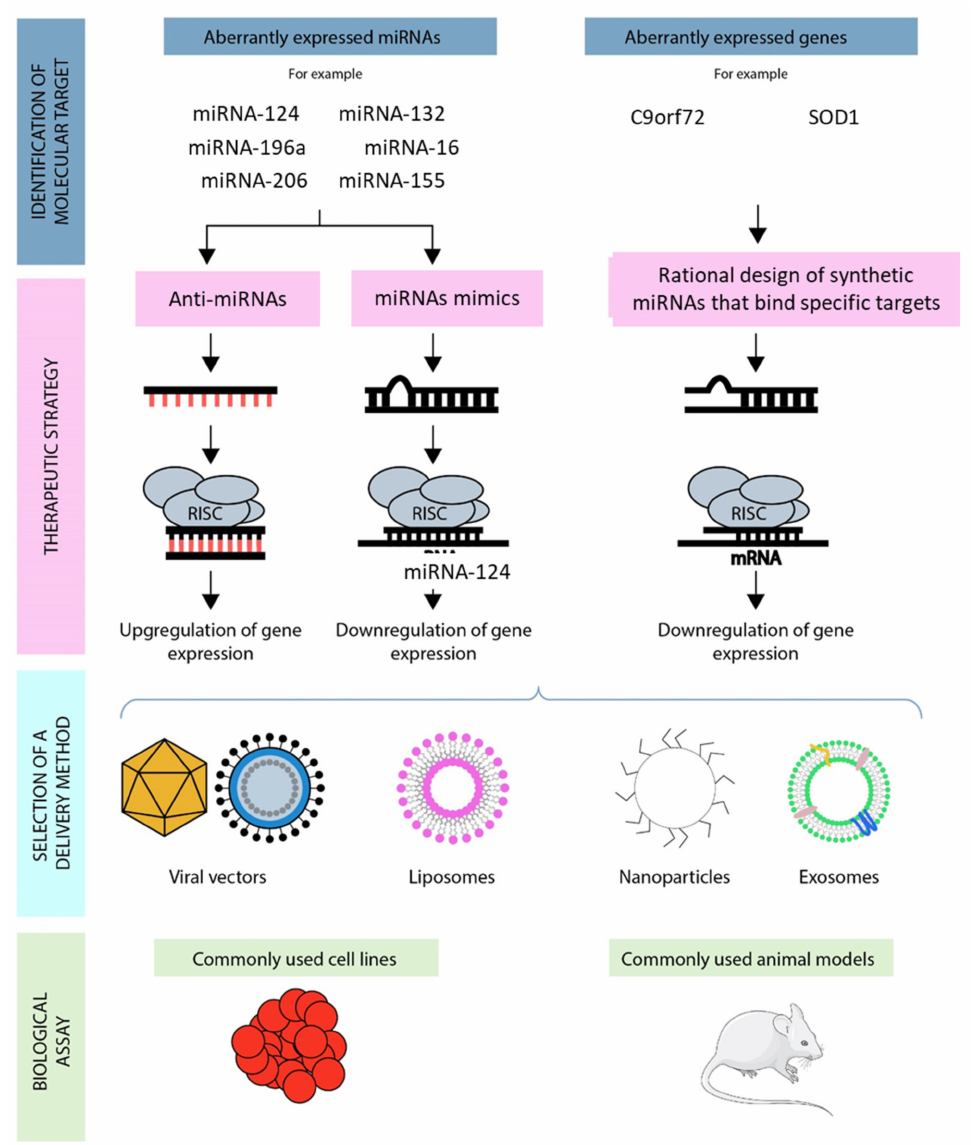
Figure 4. The steps used for designing and testing a miRNA-based therapeutic approach for neu- rodegenerative diseases. Abnormally expressed miRNAs are detected in patients’ tissues. Synthetic miRNAs are designed to target genes of interest. Specific delivery systems are designed to enter cells. The administration of miRNAs is tested in biologic